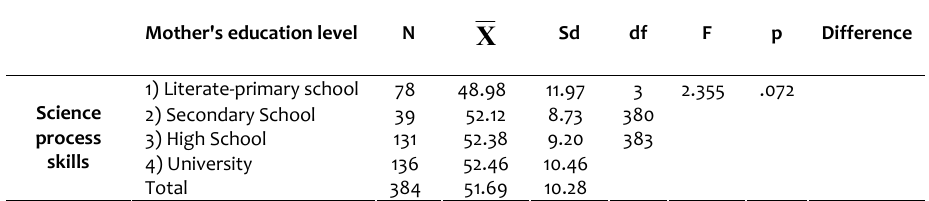
Table 15. Results of ANOVA on Science Process Skills of the 5-Year-Old Preschoolers According to Mother’s Education Level